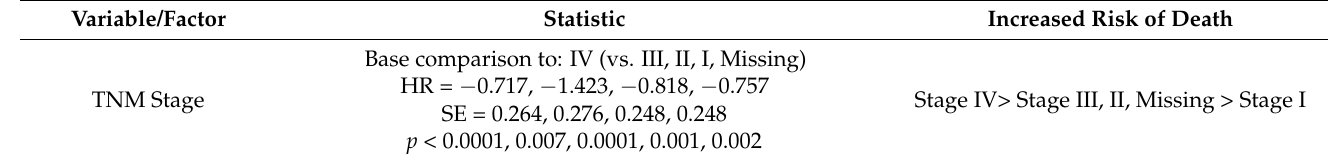
Table 11. Patient and tumor characteristics significantly predicting disease-specific (cancer-specific) survival amongst laryngeal cancer patients by multivariable Cox proportional hazard model. The initial model included all significant variables by